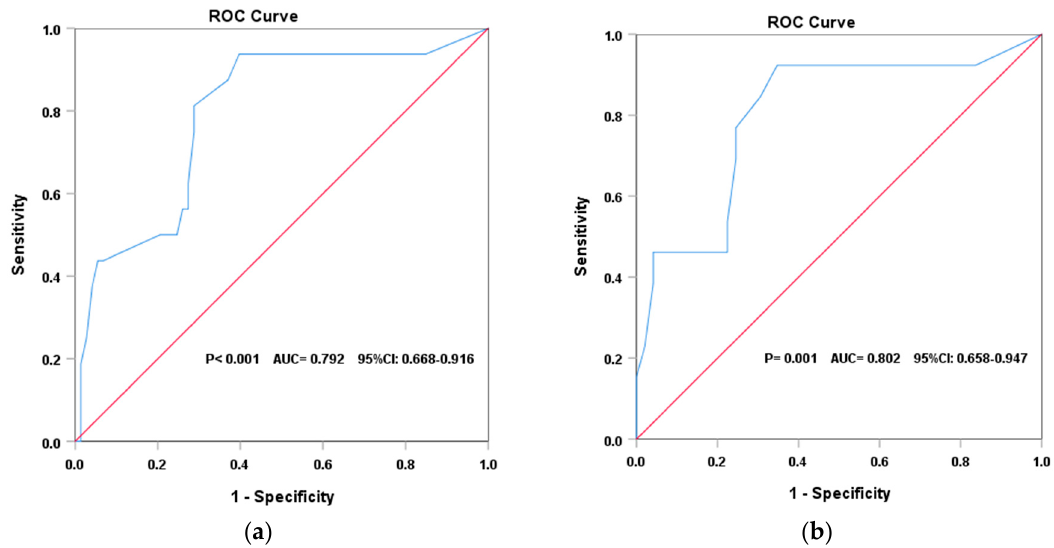
Figure 3. ( a ) Discriminative ability of the DASI to identify high-risk patients with PAH. ( b ) Discriminative ability of the DASI to identify high-risk patients with CHD–PAH.